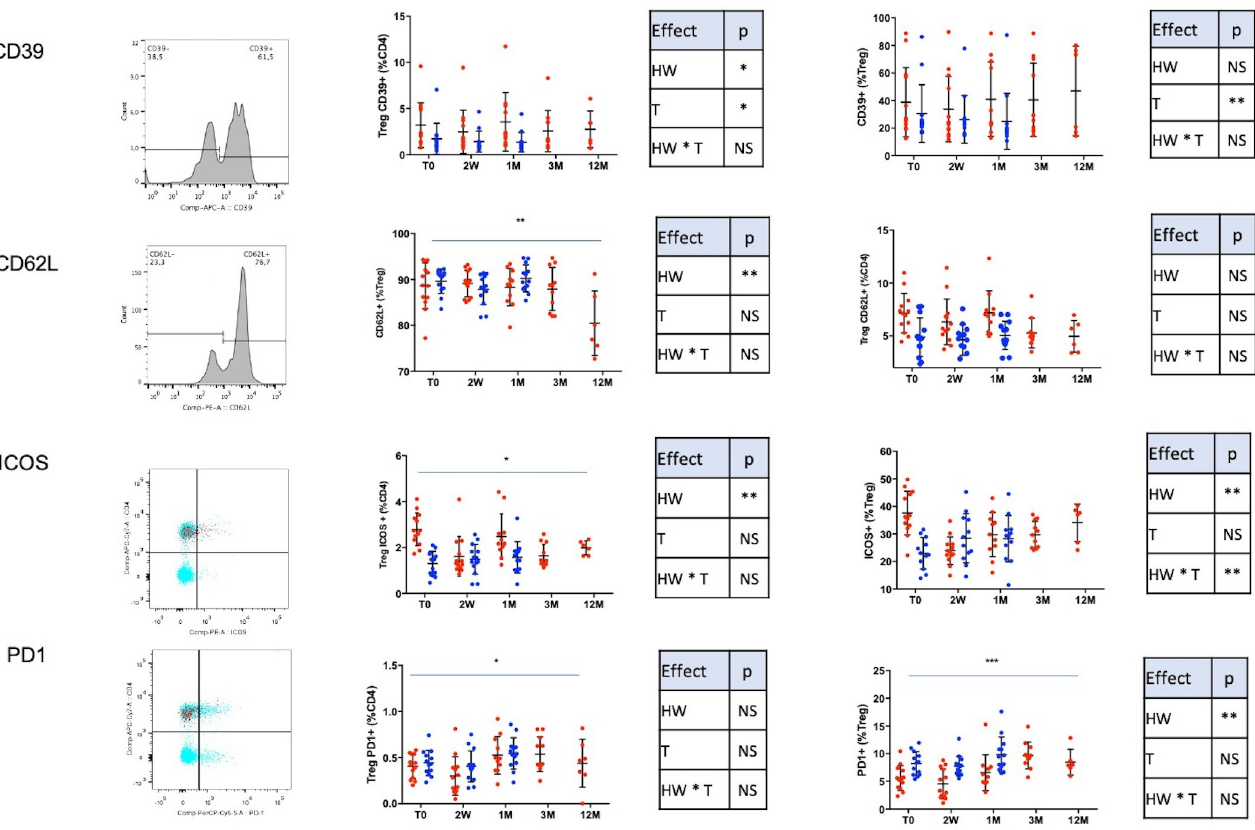
Fig 3. Treg function markers. Results are expressed as mean +/- SD. HW+: population infected with hookworm, HW-: control group, 2W: 2 weeks, 1M: 1 month, 3M: 3 months and 12M: 12 months after treatment. The HW+ group is represented with red dots and the HW- group with blue dots. Fig 3 depicted CD39 (%Treg) and Treg CD39+ (%CD4); CD62L (%Treg) and Treg CD62L+ (%CD4); costimulatory molecules ICOS(%Treg) and TregICOS, and PD-1 (% Treg) and TregPD1 (%CD4). To compare the HW+ and HW- groups and their evolution, a maximum likelihood analysis has been used to test a group (HW), a time (T) and a group � time (HW � T) interaction effects (with data at T0, 2W and 1M). Statistical results are summarized in correspondent tables for each parameter. To compare longitudinal data from the HW+ group (T0, 2W, 1M, 3M and 12M), a time and a time 2 effects were tested. The time effect is depicted on the figures and the time 2 effect is given in the results section ( � p < 0.05, �� p < 0.01, ��� p < 0.001).